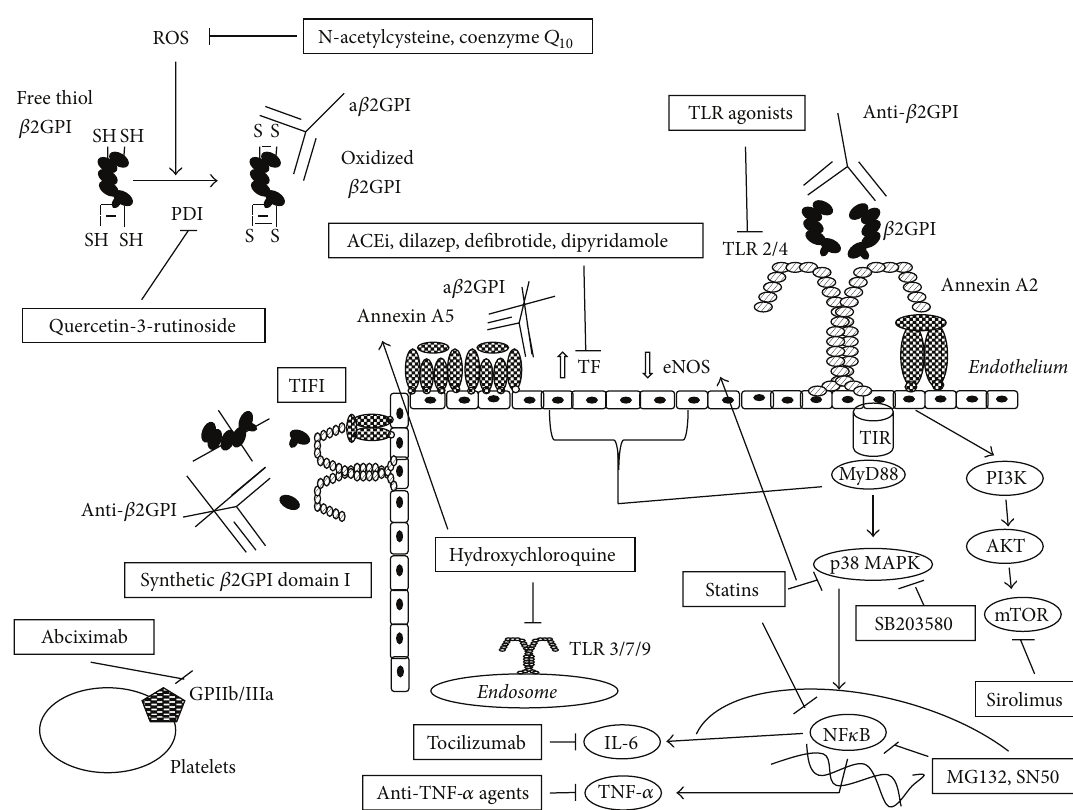
Figure 1: Mechanisms of action of potential future therapeutic tools in APS. ROS: reactive oxygen species; 𝛽 2GPI: 𝛽 2 glycoprotein I; a 𝛽 2GPI: antibodies against 𝛽 2GPI; PDI: protein disulfide isomerase; ACEi: angiotensin-converting enzyme inhibitors; TLR: Toll-like receptor; TF: tissue factor; eNOS: endothelial nitric oxide synthase; GP: glycoprotein; IL: interleukin; TNF: tumour necrosis factor; PI3K: phosphatidylinositol 3-kinase; mTOR: mammalian target of rapamycin.